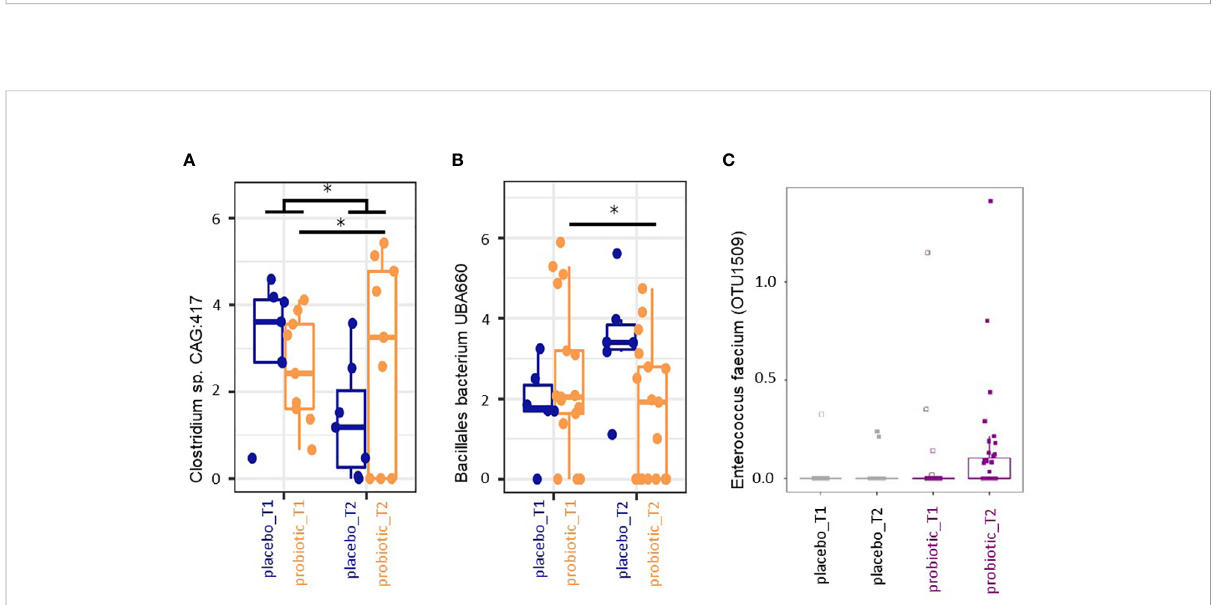
FIGURE 4 (A, B) Box plot analysis of mixed model analysis of centred and log-ratio transformed (CLR) abundances. Taxa with relative abundances of at least >0.5% in at least 10 samples across all timepoints were included. *p<0.05 in the mixed model analysis. (C) Differential abundance in percent of Enterococcus faecium determined by MaAsLin2 between the two time points for the probiotic and the placebo